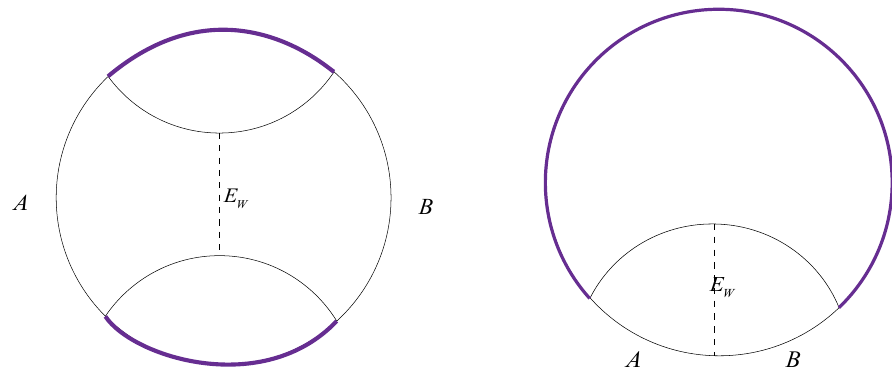
Figure 1 . The gap (denoted by purple curves) between two boundary regions A and B of a time slice of AdS 3 vacuum. The lower bound of the Markov gap for the left phase is 2 c for the right as there is no boundary on asymptotic infinity.